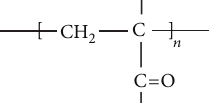
Table 1: Composition of denture base materials (heat